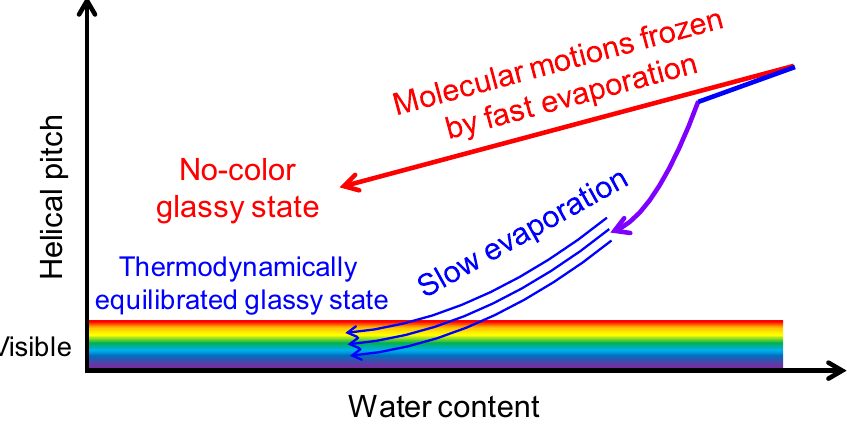
Figure 9. Qualitative model of the effects of fast and slow water evaporation on the helical